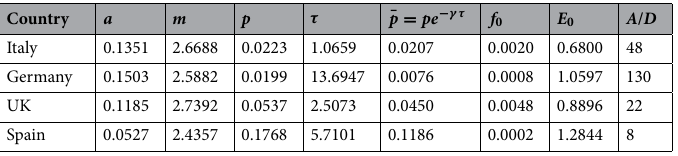
Table 4. Parameter sets from continuum model yielding the lowest value of E 0 and subsidiary quantities.